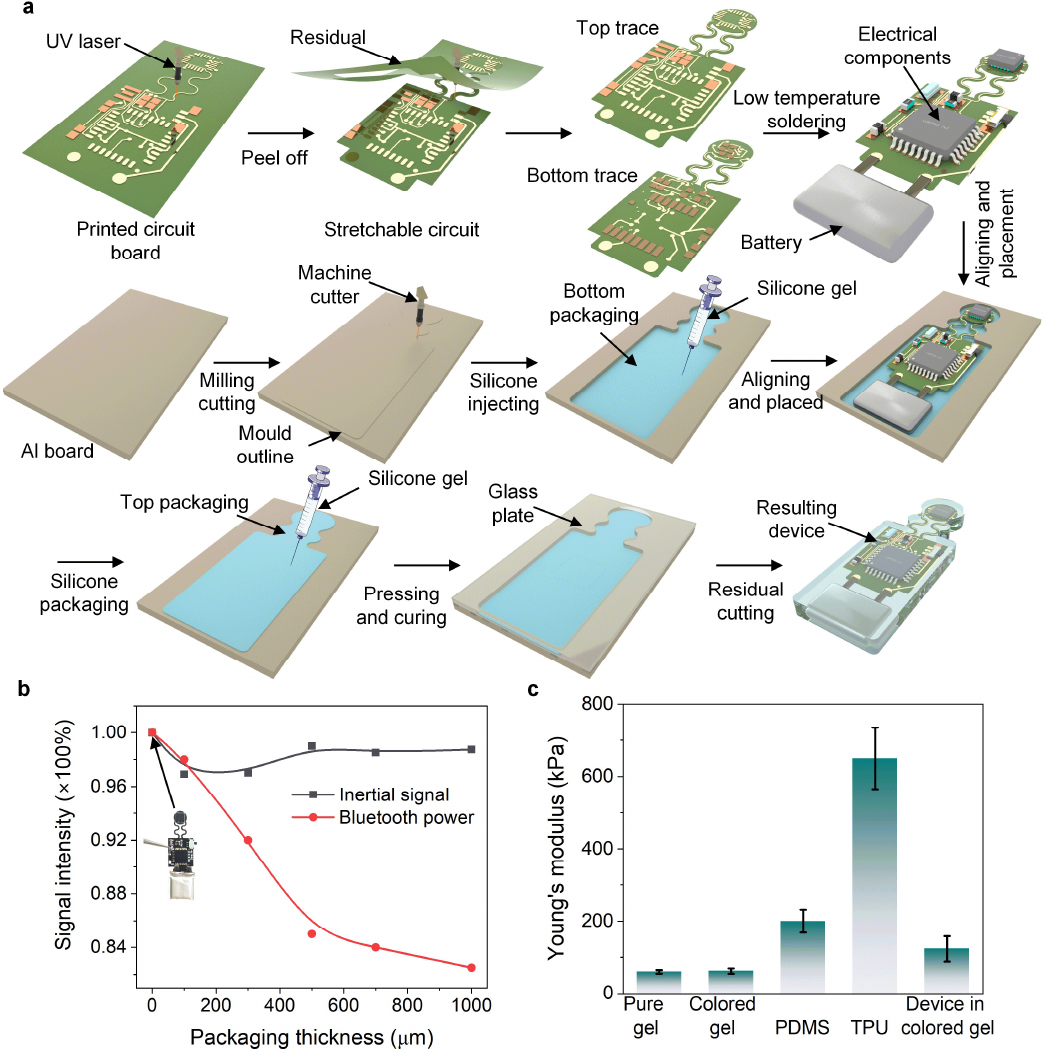
Figure 2. Fabrication of the AID. ( a ) Laser engraving of the stretchable bare circuit and the encap- sulation. ( b ) Variations in the signal intensity of the inertial signal and Bluetooth output with varying thicknesses of packaging silicone gel. ( c ) Tested Young’s moduli of different elastomers and the AID encapsulated by the colored silicone.